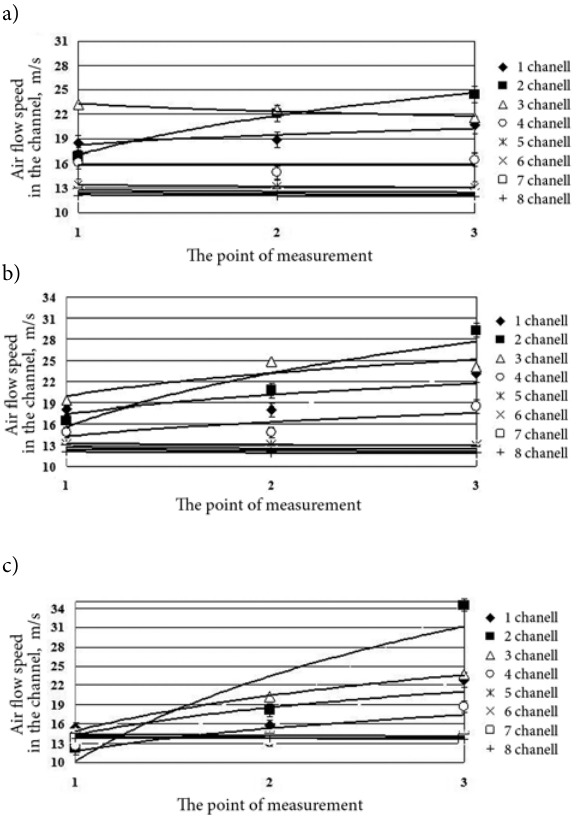
Fig. 5. Distribution of airflow velocities in 8-channel cyclone’s channels when solid quarter-rings are used: a) peripheral airflow volume is by 50% smaller than transit airflow volume (25/75); b) peripheral airflow volume is equal to transit airflow volume (50/50 position); b) peripheral airflow volume is by 50% larger than transit air volume (75/25 position)